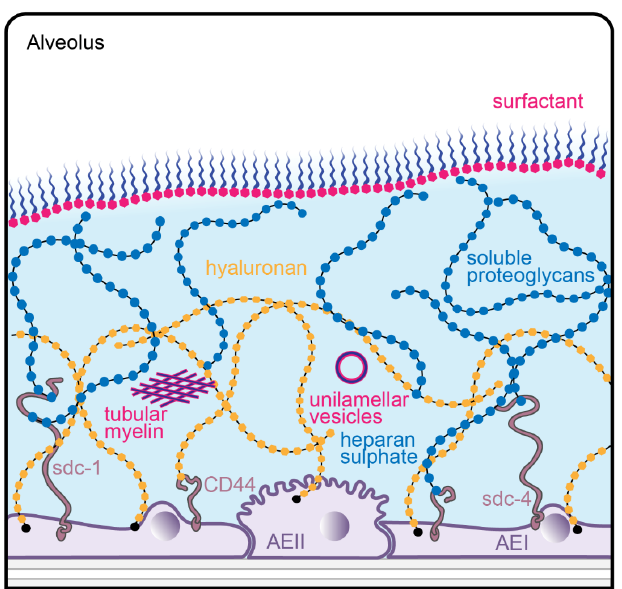
Figure 1. Schematic diagram of the alveolar lining layer with surfactant and glycocalyx components. Surfactant is present at the surface film and in the hypophase. Surfactant subtypes in the hypophase correspond to different stages in metabolism, shown here as active tubular myelin and inactive unilamellar vesicles. Proteoglycans of the glycocalyx can be attached to the apical membrane of type I (AEI) or type II (AEII) alveolar epithelial cells by syndecans like syndecan-1 (sdc-1) or syndecan-4 (sdc-4). Hyaluronan can bind either to its receptor CD44 or intercalates throughout the glyxcocalyx. The alveolar lining layer and its contents are not drawn to scale.